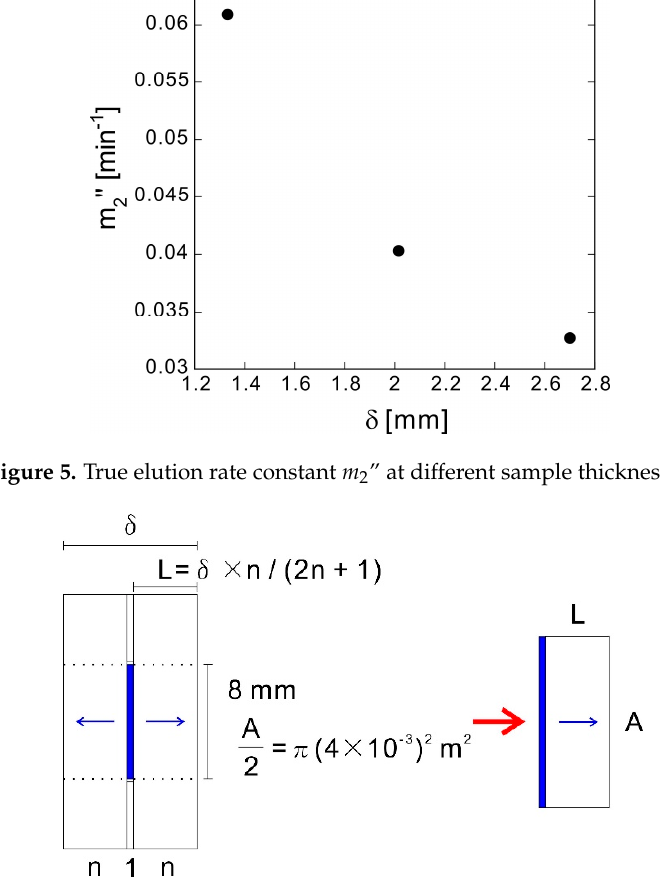
Figure 6. Diffusion model for the release of the drug from the tablet.